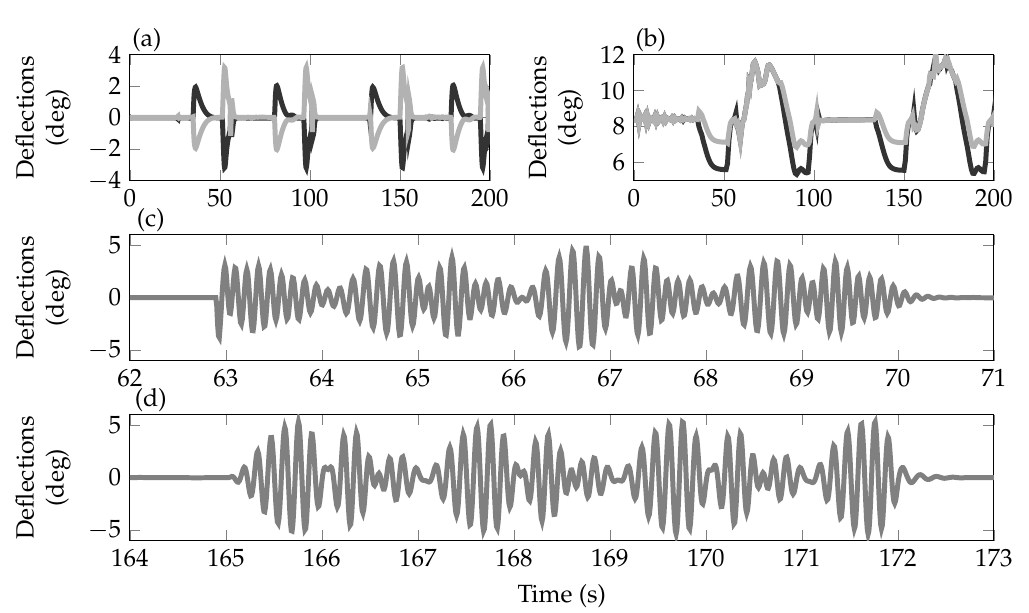
Figure 12. Control surface activity during the simulated flight for the two left and two right ailerons controlling the roll motion in ( a ), the two left and right ruddervators in ( b ), and the two ailerons stabilizing the two flutter in ( c , d ) for the phases when the flutter suppression controller is